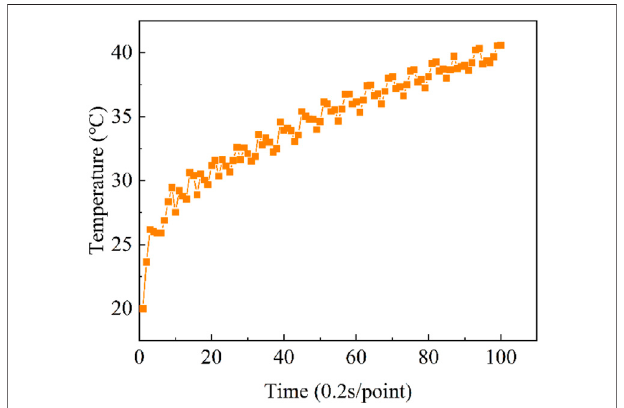
FIGURE 4 | The relationship between the temperature and processing